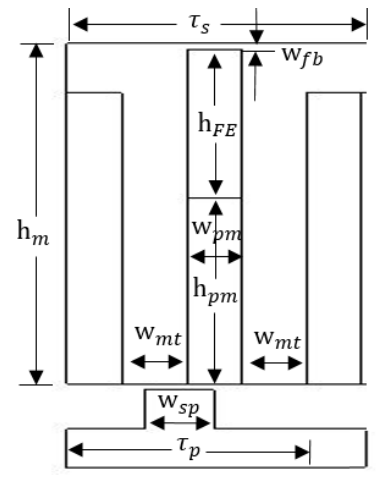
Figure 2. Design parameters of proposed single-sided